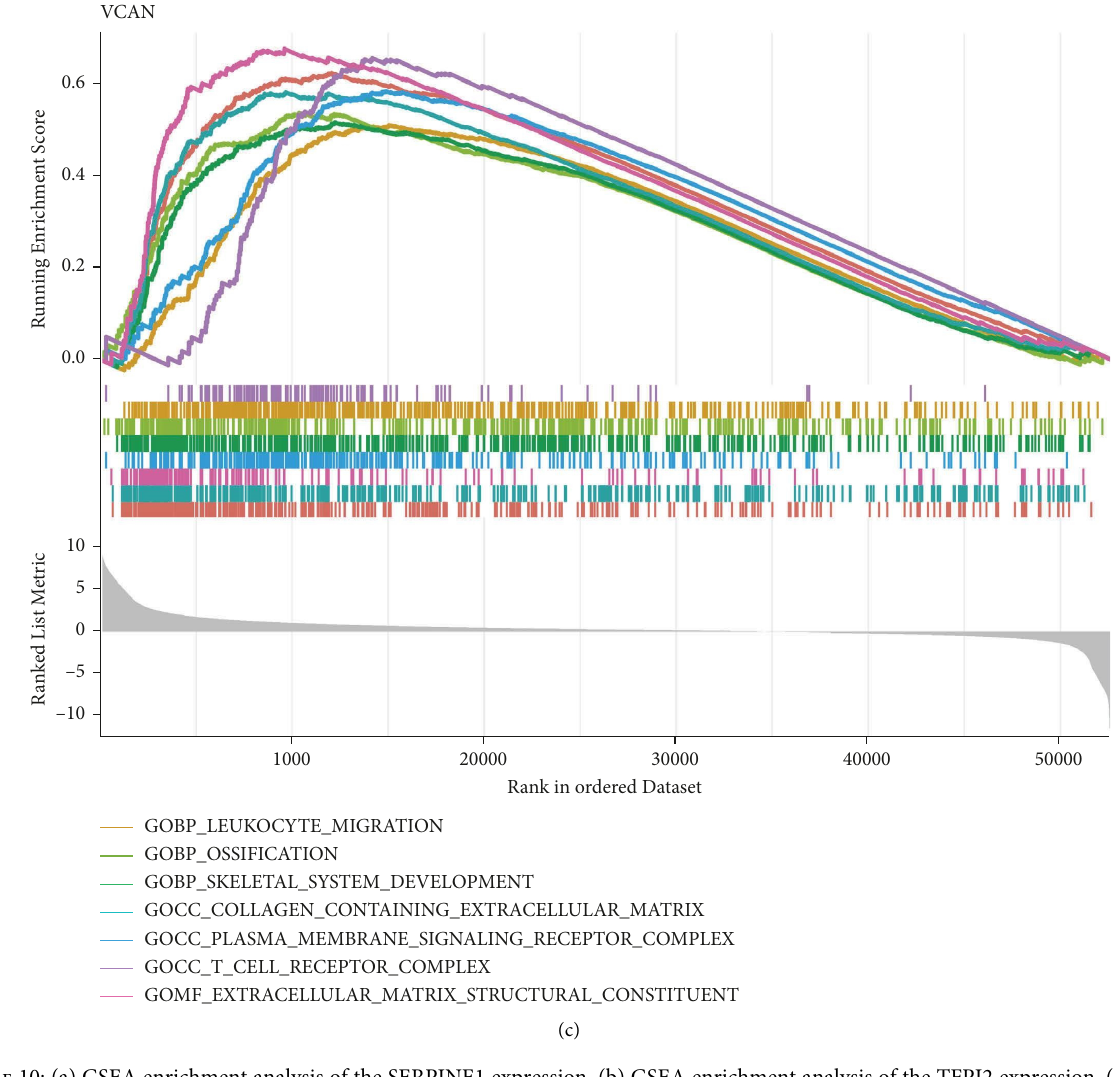
Figure 10: (a) GSEA enrichment analysis of the SERPINE1 expression. (b) GSEA enrichment analysis of the TFPI2 expression. (c) GSEA enrichment analysis of the VCAN